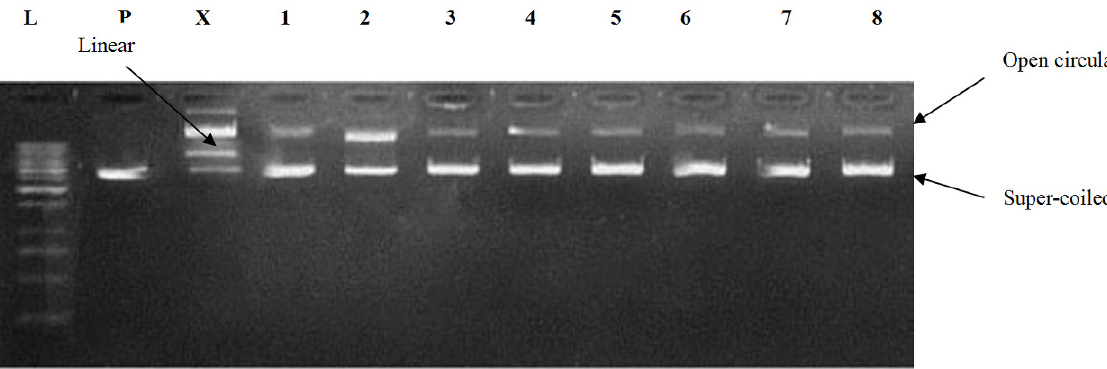
Figure 5. Effect of karanjachromene and karanjin on pBR322 plasmid DNA. L = ladder (1 KB), P = Plasmid (pBR322), X = pBR322 plasmid treated with